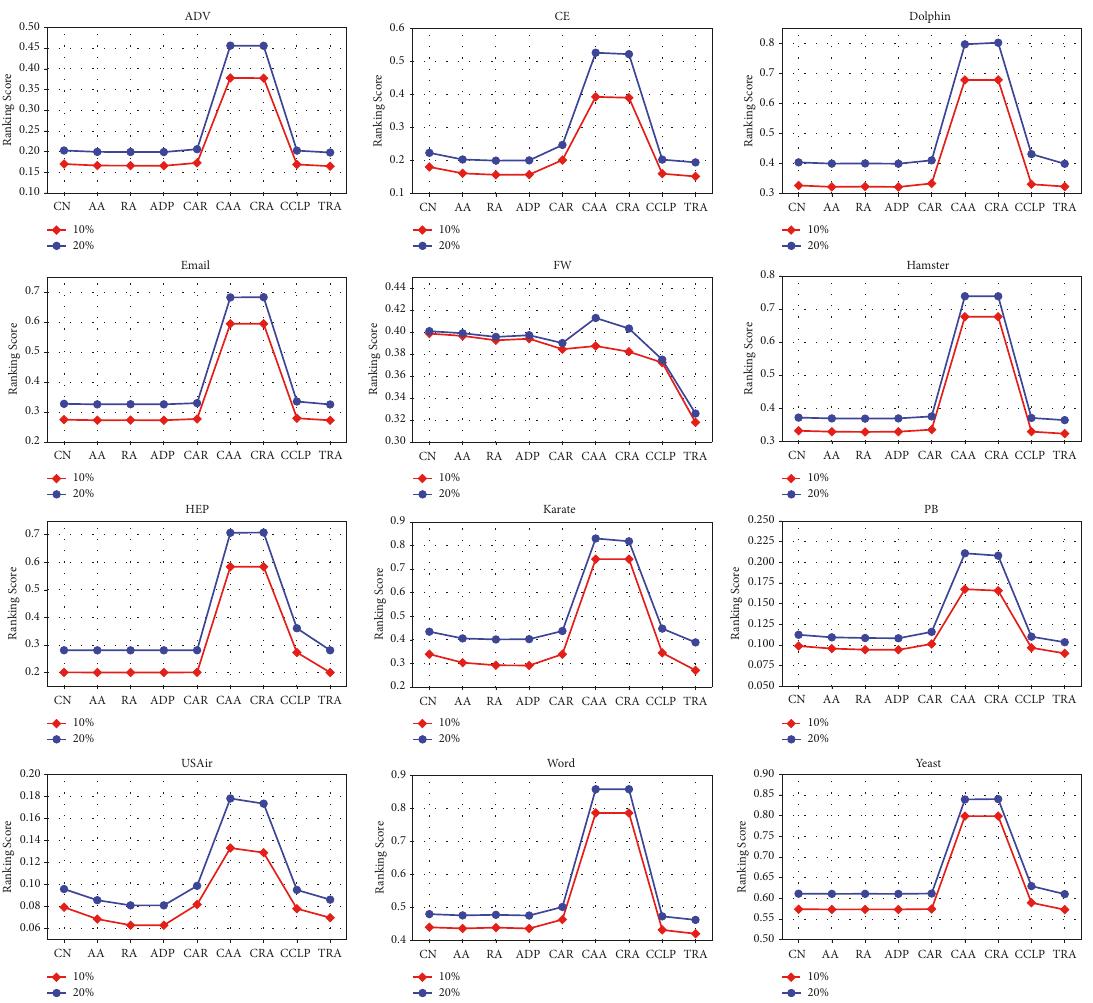
Figure 5: The changes of ranking score when |𝐸 𝑡𝑠 |/|𝐸| increases from 10% to 20% on 12 networks. Each point is obtained by averaging over 50 independent